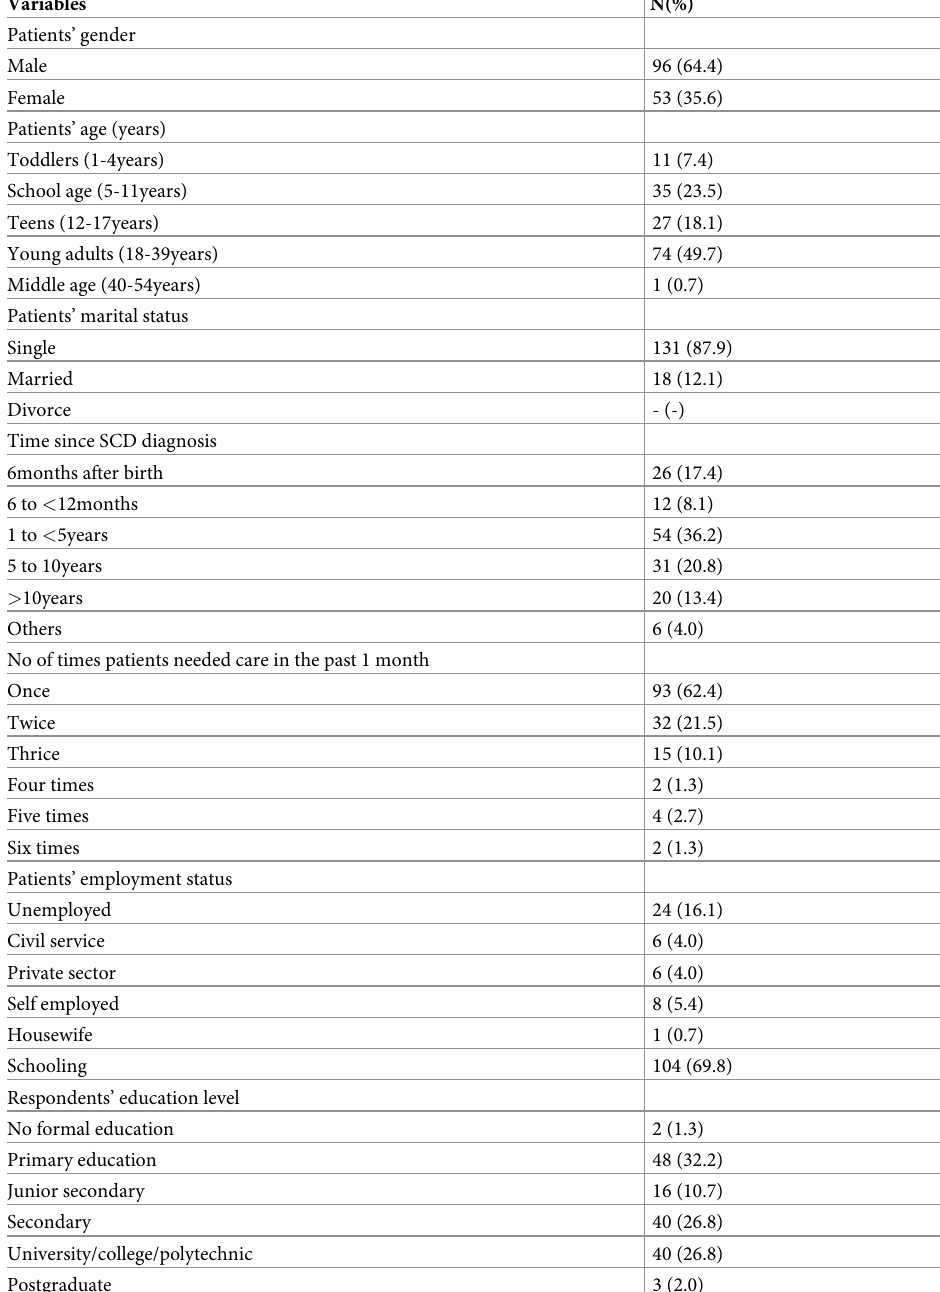
Table 1. Selected socio-demographic characteristics of the patients and